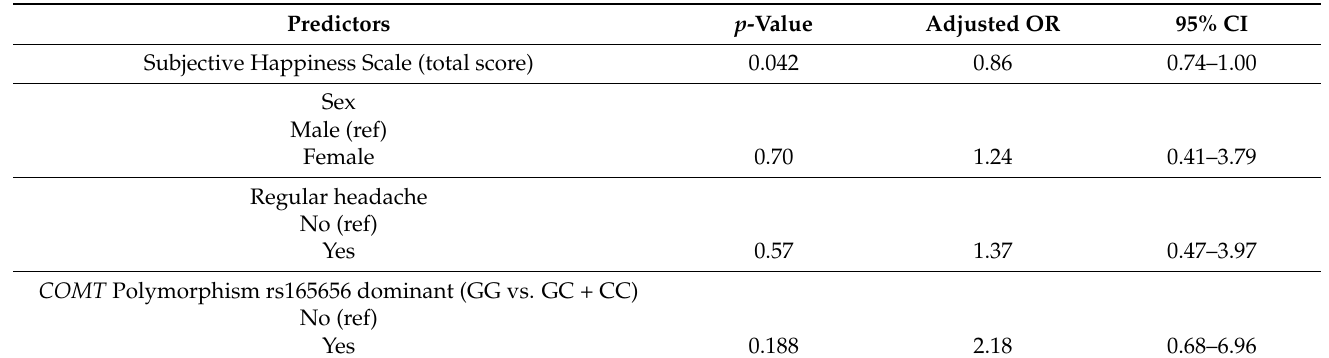
Table 6. Multivariate logistic regression model for chronic pain in